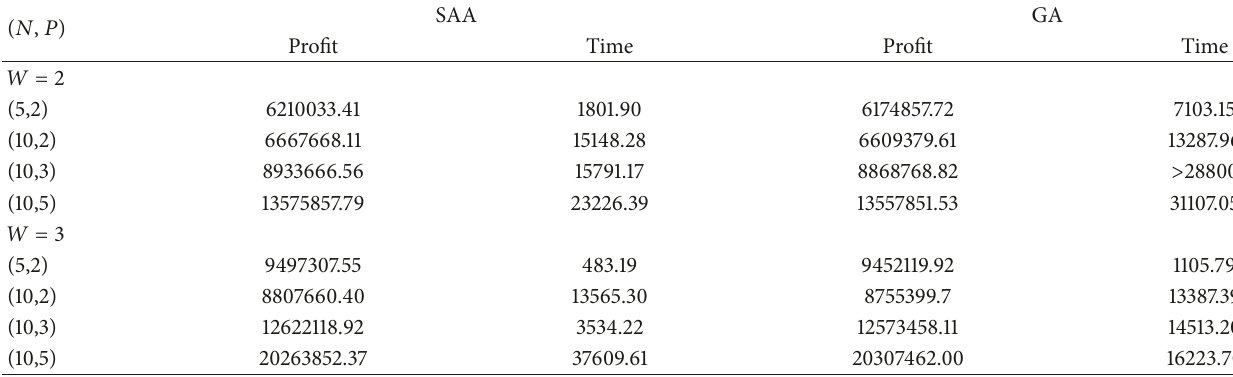
Table 1: Computational results obtained when solving the stochastic programming model.